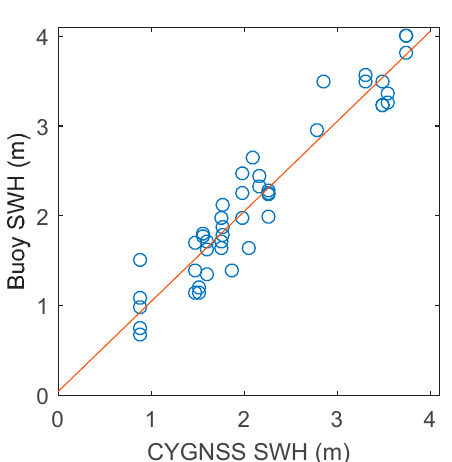
Figure 13. Discrete distribution of CYGNSS SWH estimates and buoy SWH measurements on April 1, 2017.